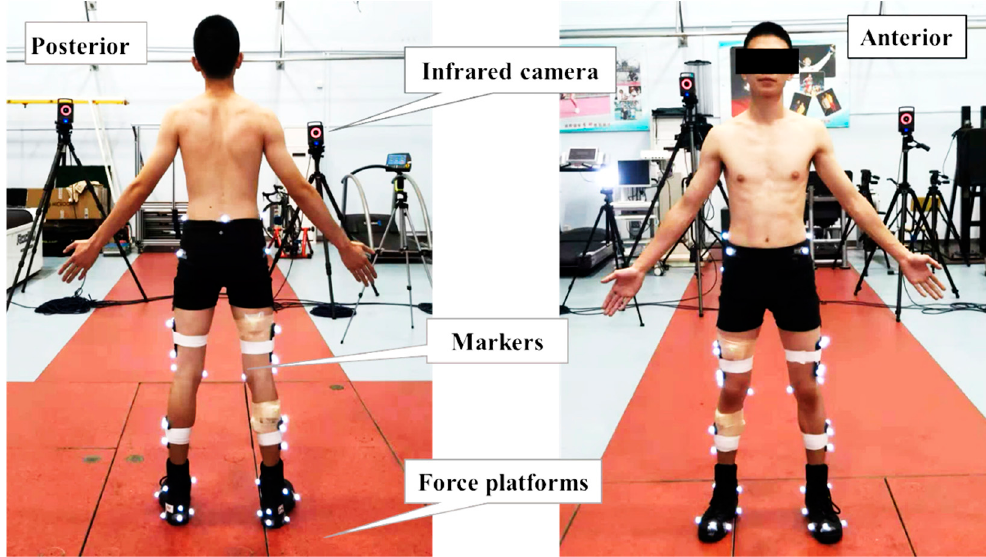
Figure 2. Set of reflective markers used in the study and the experimental setup.